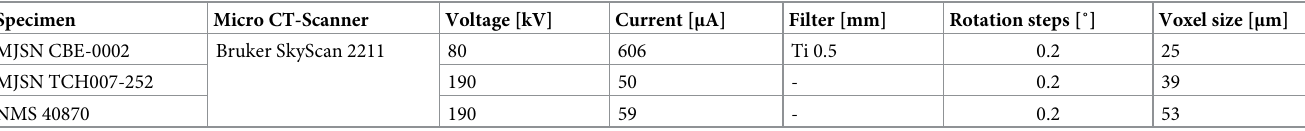
Table 1. Scan specifications for the examined